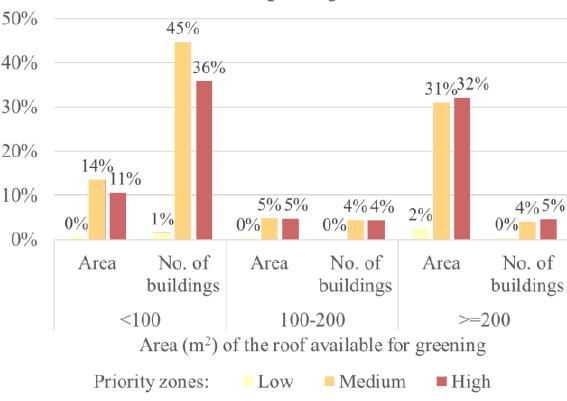
Figure 6. Area-wise and priority-wise percentage of total potential roofs (Area and number of